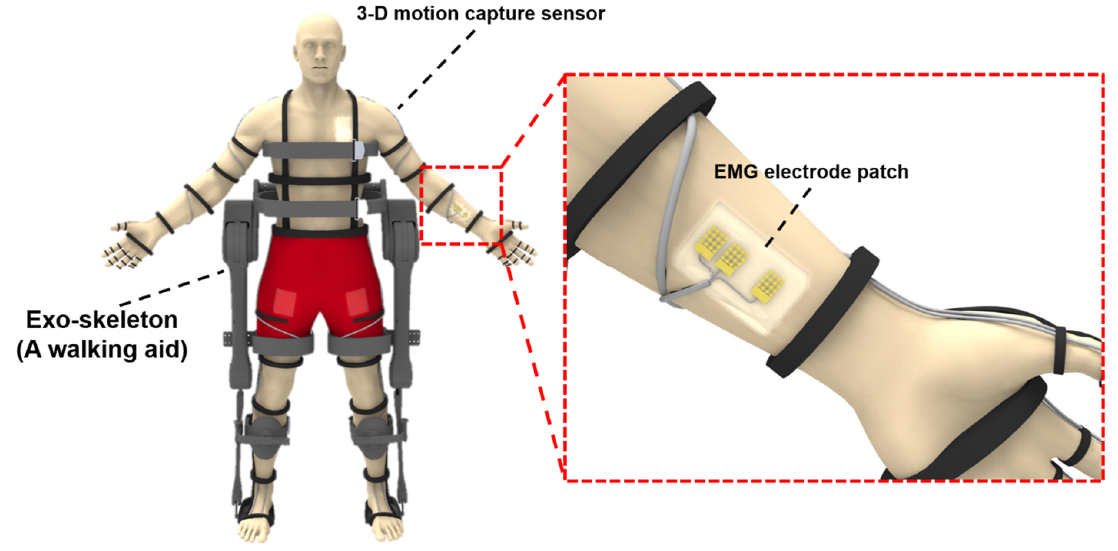
Figure 1. Schematic of a walking aid exoskeleton and the skin-attachable electromyographic (EMG) electrode patch.